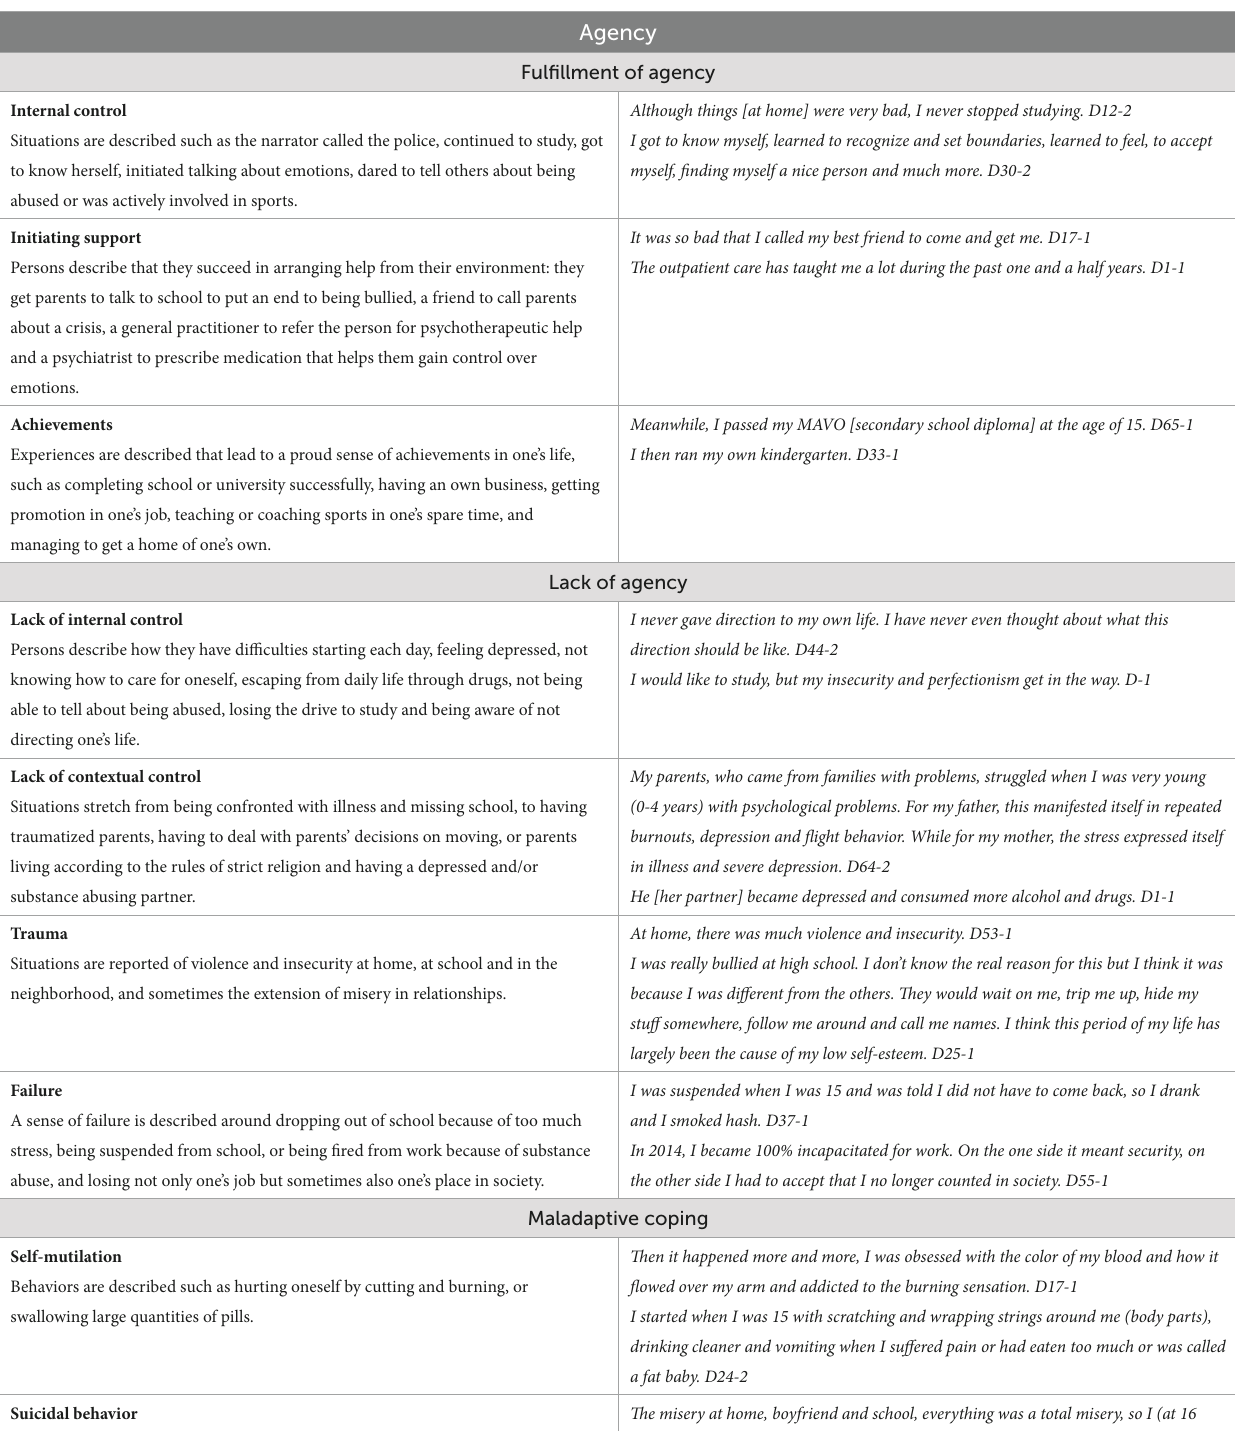
Agency Fulfillment of